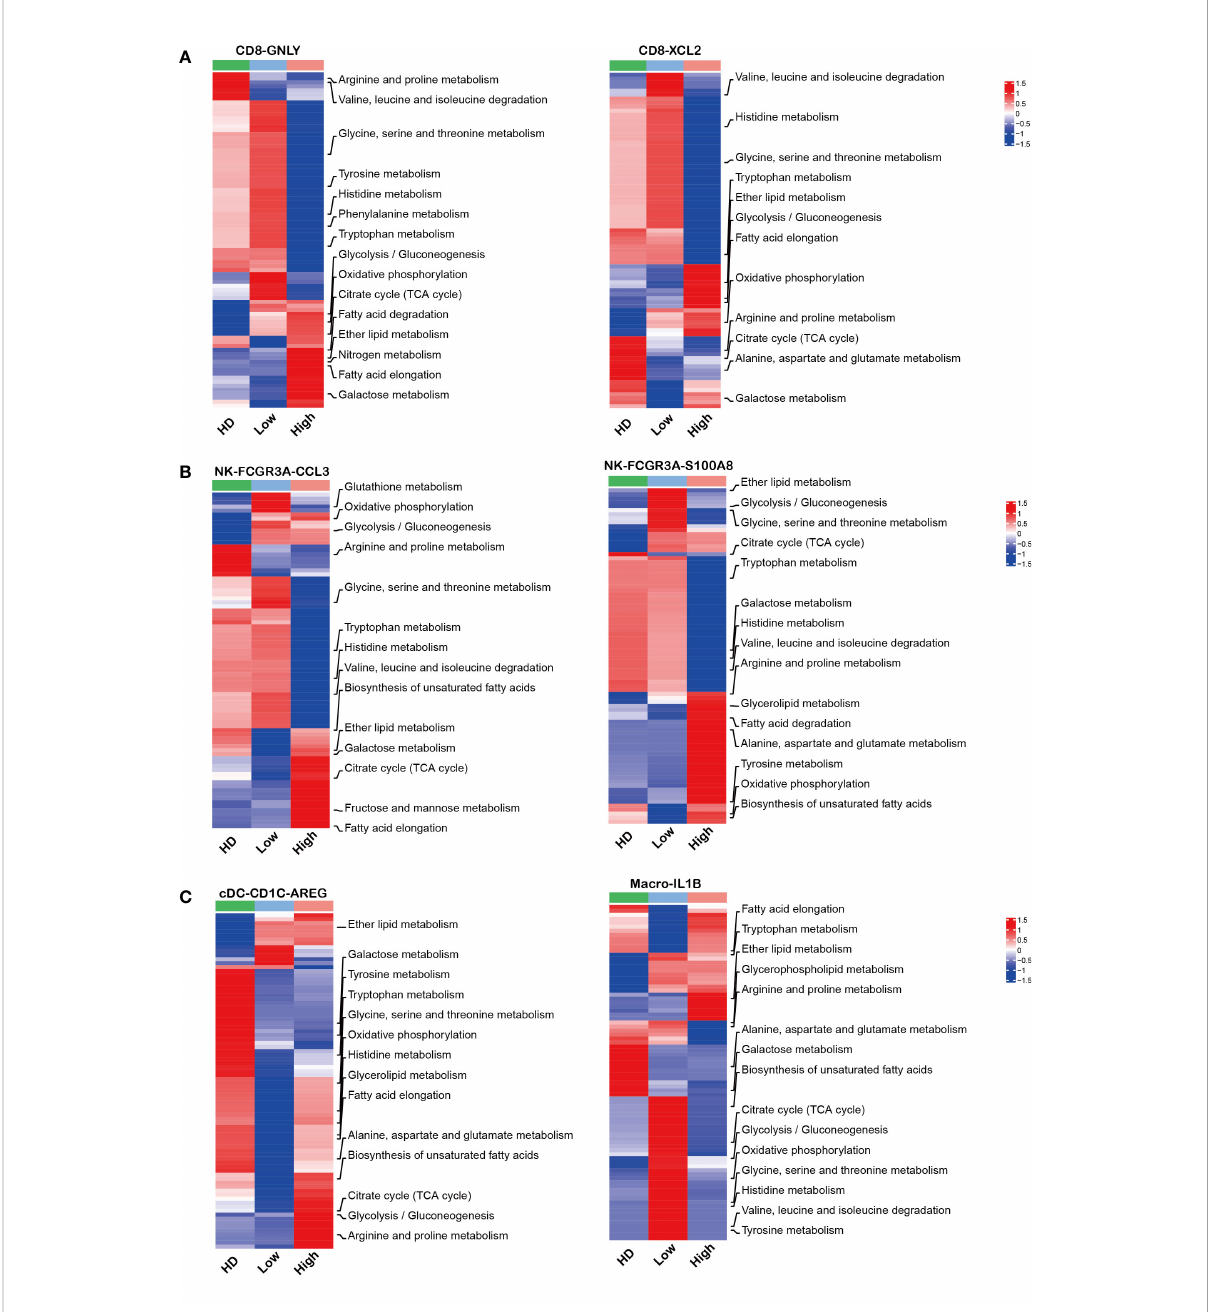
(Figure 6C). The variation of metabolic pathways in immune cells according to diverse tumor cell in fi ltration suggested that the disordered metabolism also induced the dysfunction of immune cells in MM